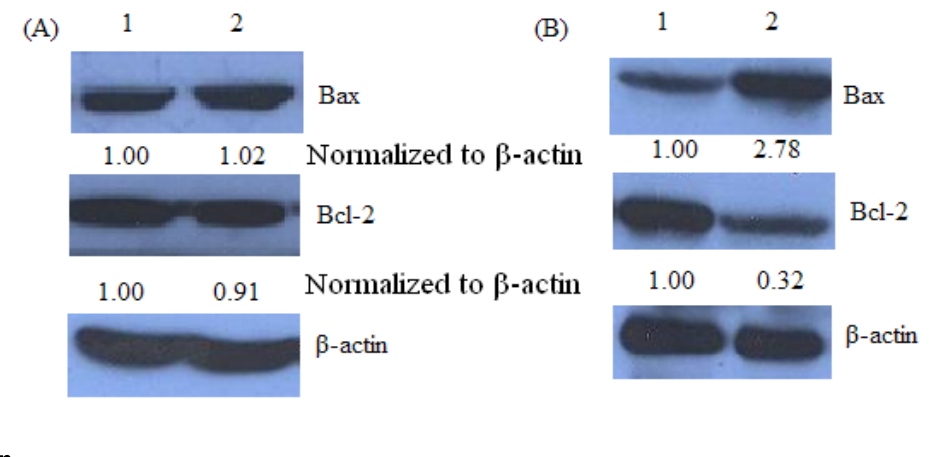
Figure 6. Tamoxifen-mediated up-regulation of Bax and down regulation of Bcl-2 by Western blot assay. Keloid fibroblast cells or pCMV6-C DK10 -keloid were treated with 8 µM tamoxifen for 48 h, respectively. The blots were stripped and reprobed with anti- β -actin antibody to normalize protein loading. Fold change was calculated as described in Figure